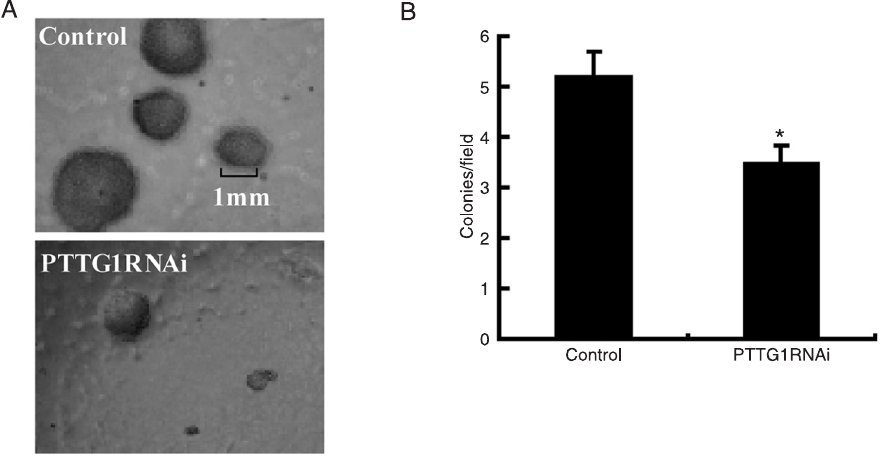
Figure 2. Pituitary tumor-transforming gene-1 (PTTG1) knockdown reduced PC3 cell colony forma- tion. A , Colonies of PTTG1RNAi and control PC3 cells larger than 1 mm in diameter were counted. The light micrographs show colonies formed after 3 weeks of growth on soft agar. B , The number of PC3 colonies was significantly reduced by PTTG1 knockdown (*P < 0.05, Student t -test) compared to control. The bar graph shows the mean number of colonies in 10 low-power fields for each cell